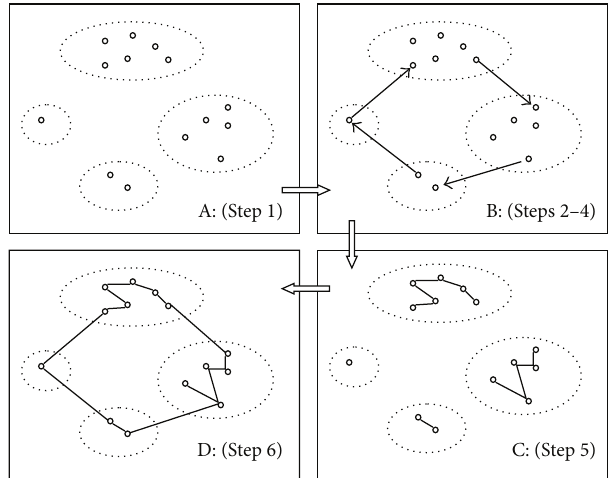
Figure 3: The schematic diagram of ACO-SLC. Firstly, classify all points into compact classes. Secondly, the centroid of each class is regarded as a virtual city; calculate a virtual TSP route. Then along the virtual route, join all classes. Thirdly, let ACO act on each class to get a local TSP route. Fourthly, join all local TSP routes along the virtual route to form the last route.